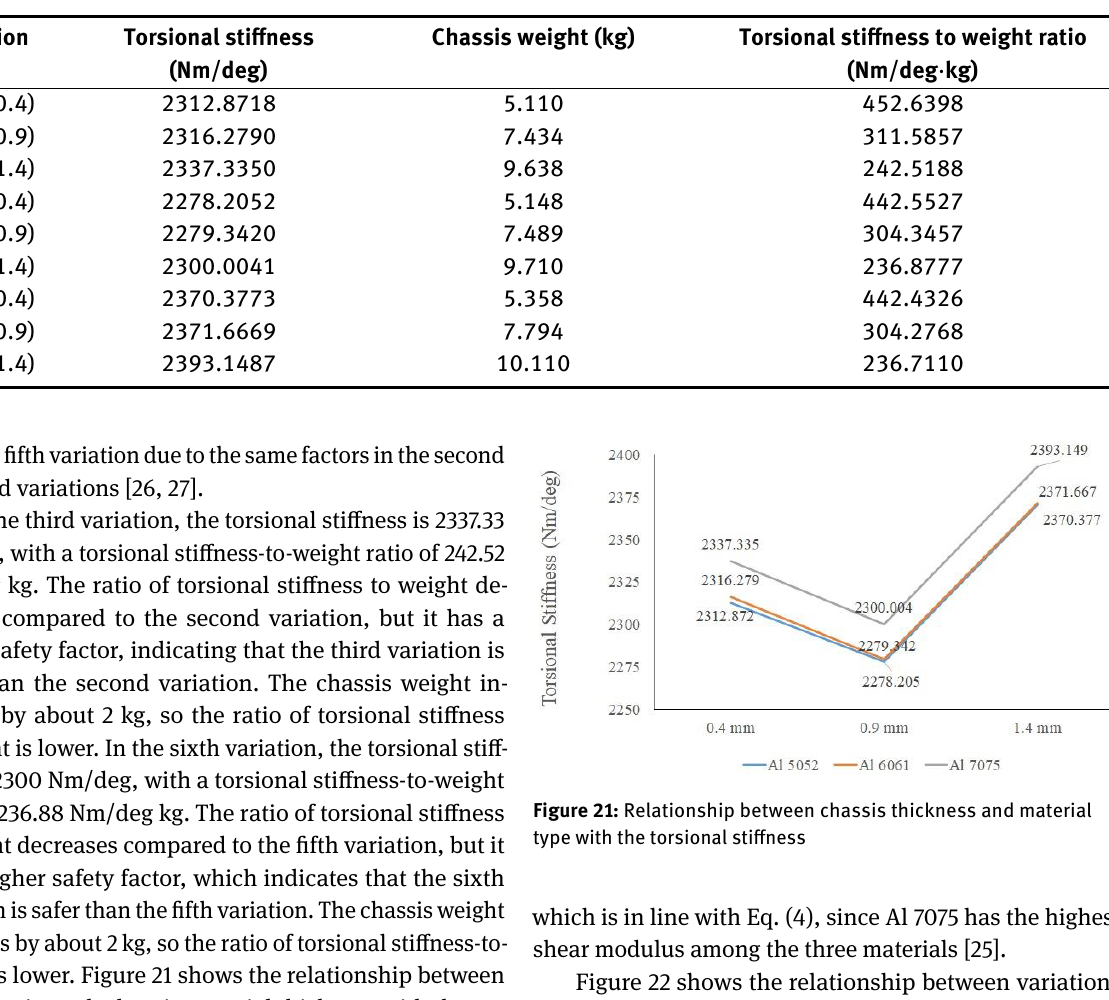
which is in line with Eq. (4), since Al 7075 has the highest shear modulus among the three materials